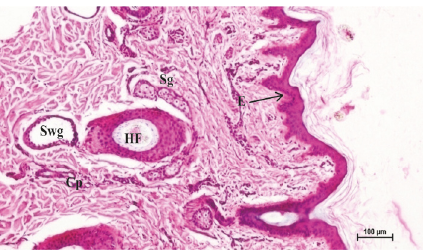
Figure 10:Photomicrographfrom tail lateralregion of skin showing Epidermis(E),hairfollicle(HF),capillarynetwork(Cp),sweatgland (Swg), and Sebaceous gland (Sg). Hematoxylin and Eosin X 100.